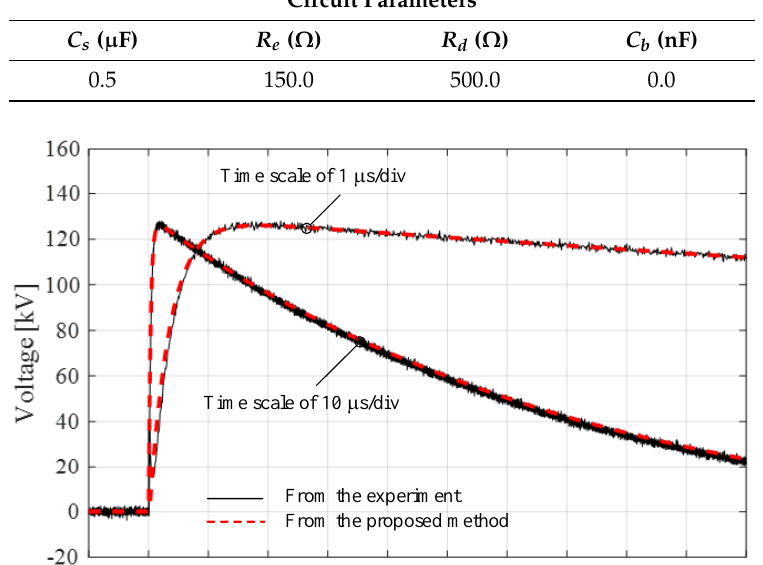
Figure 27. Comparison of the generated impulse voltage waveforms collected from the experiment and computed by the proposed method.